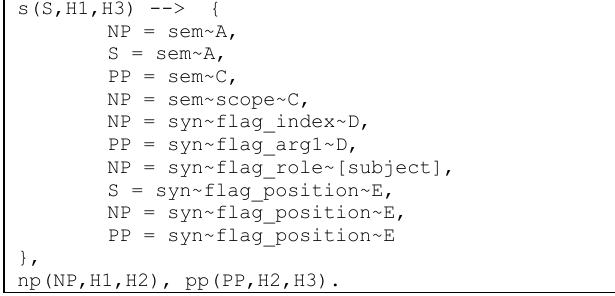
Figure 2. Analyse the sentence with the first structure based on framework GULP